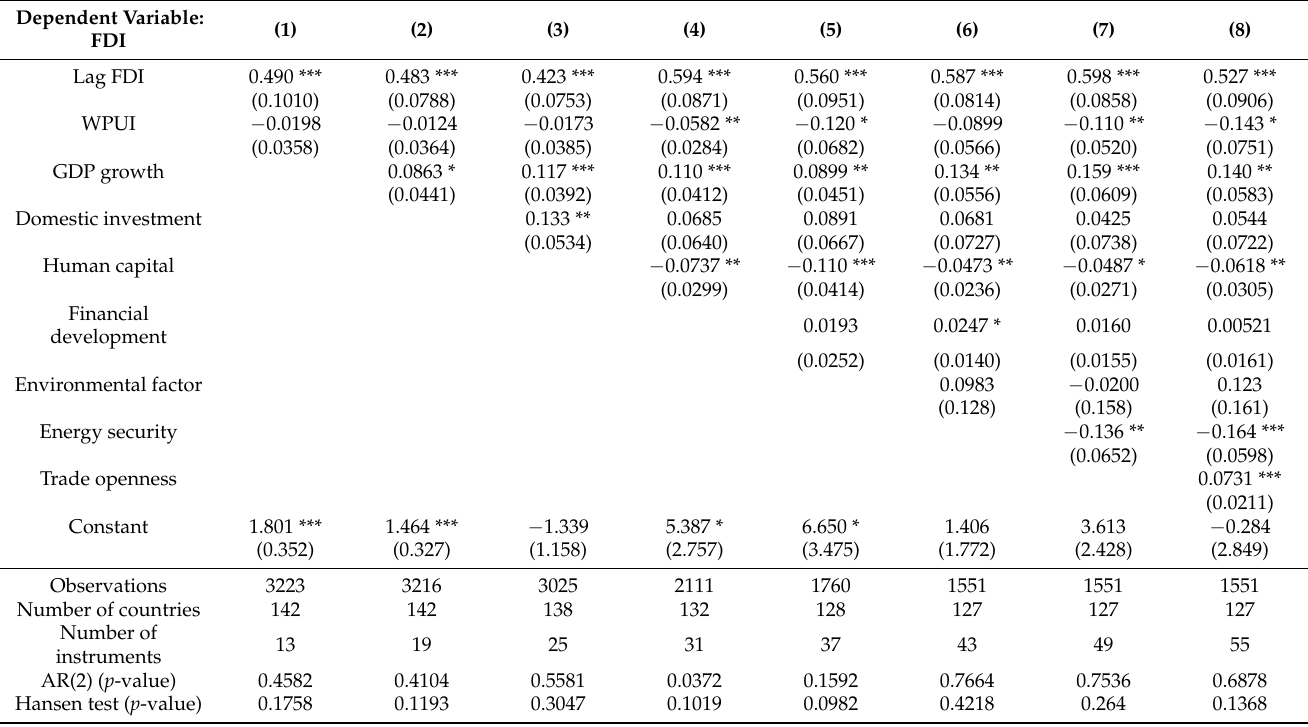
Table 2. World Pandemic Uncertainty Index and